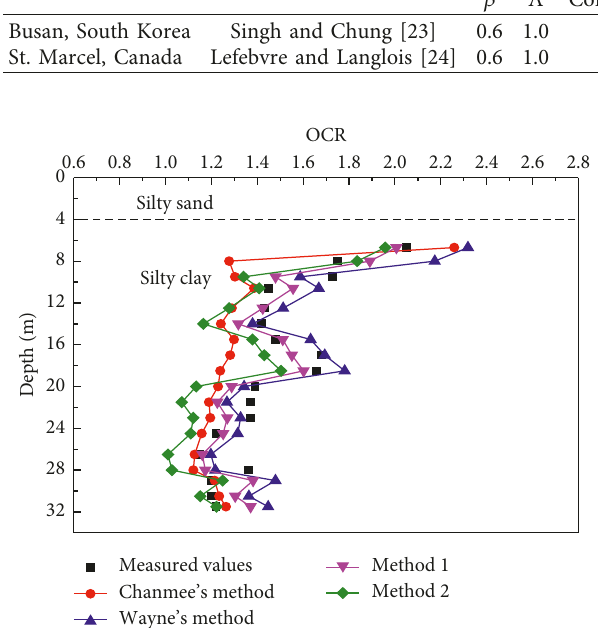
Figure 6: The predicted values of OCR by four methods for Busan site in Korea based on CPTU.